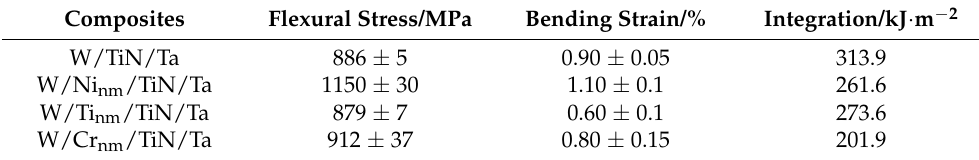
Figure 3. Element line-scan results of W/Ta and W/TiN/Ta-laminated composites joined at 1400 °C: ( a , b ) W/Ta, ( c , d ) W/TiN/Ta.